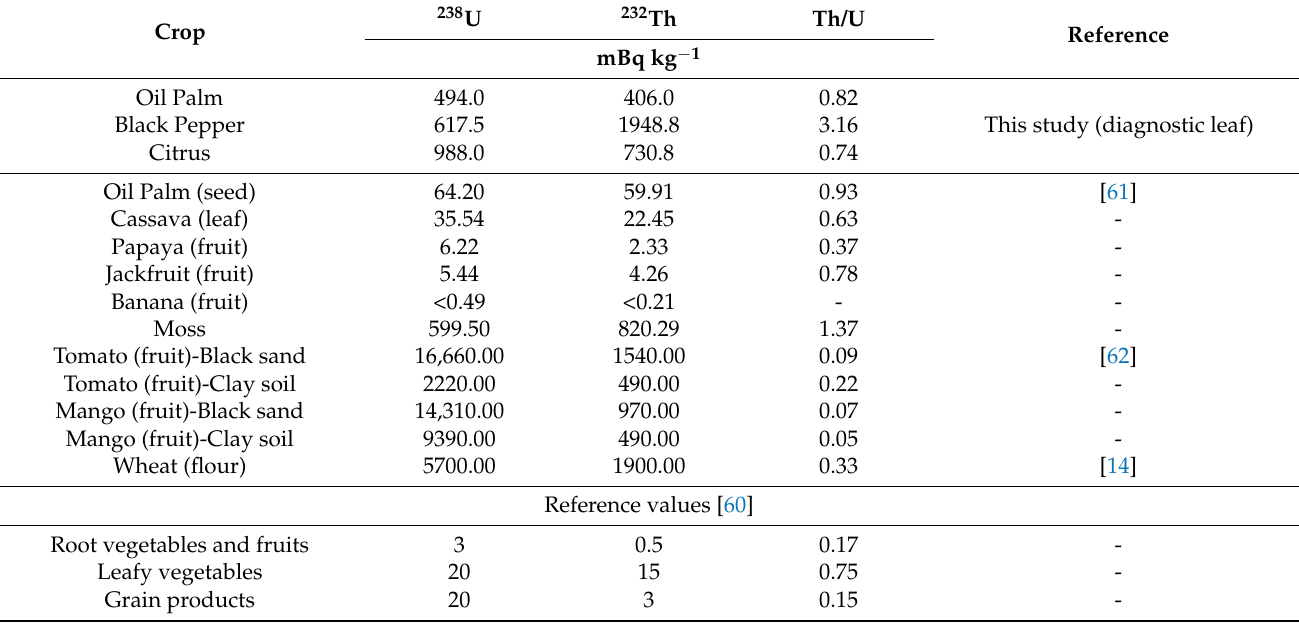
Table 3. Activity concentrations of uranium and thorium in the studied crops and in previous studies, and reference values.